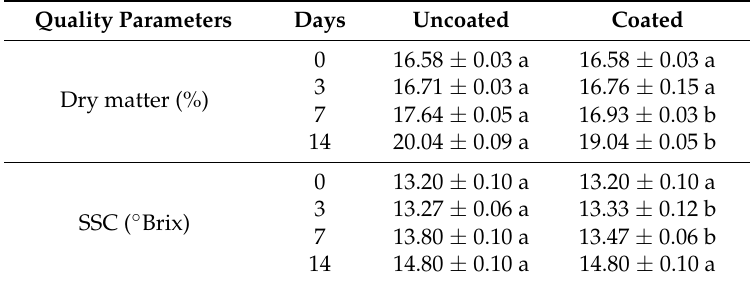
Table 2. Dry mass (%), soluble solids content (SSC) ( ◦ Brix) in uncoated and coated blueberries fruit. Fruit were stored at 16 ◦ C for up to 14